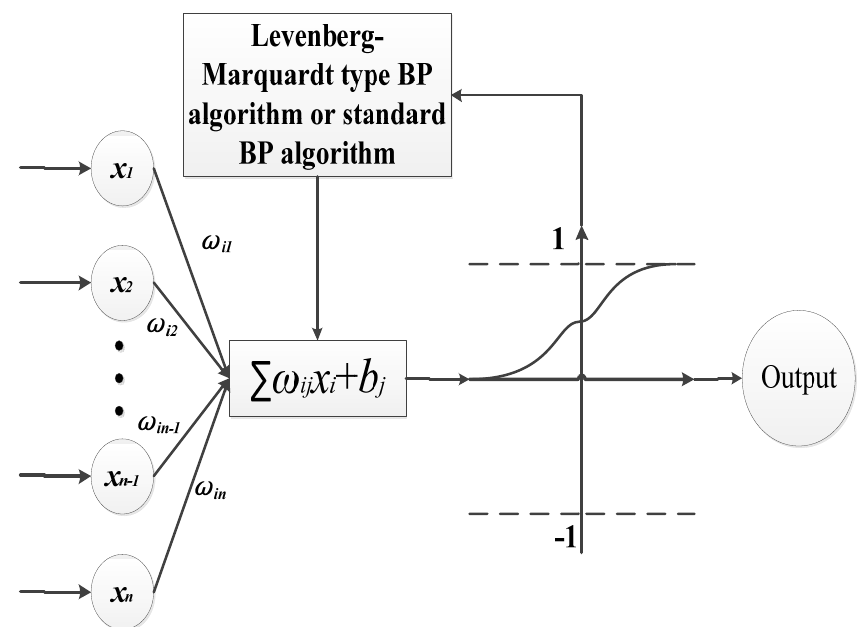
Figure 1. System of typical artificial neural networks (ANN) model. A typical ANN model has input, sum function, log ‐ sigmoid activation function, and output.